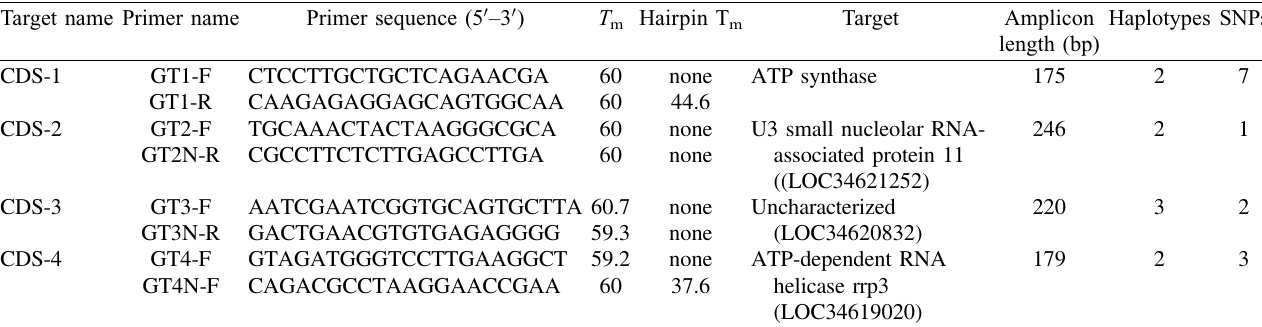
Table 1. Characteristics of the four primer sets used to amplify the marker regions. Target name Primer